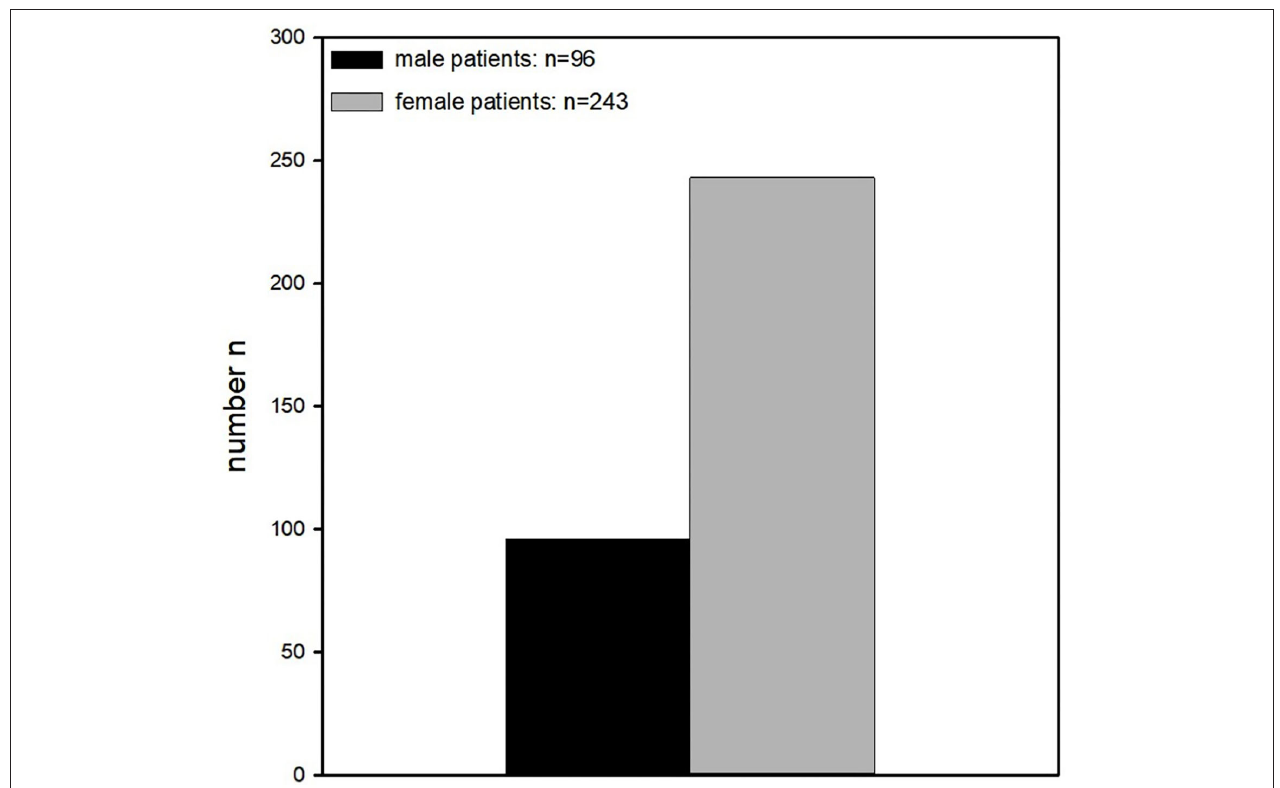
FIGURE 2 | Gender distribution. Significantly more women than men were enrolled in this study (96 vs. 243).